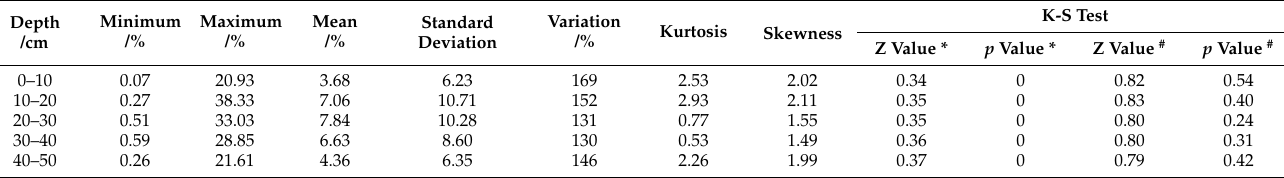
Table 2. Descriptive statistics of soil moisture at different